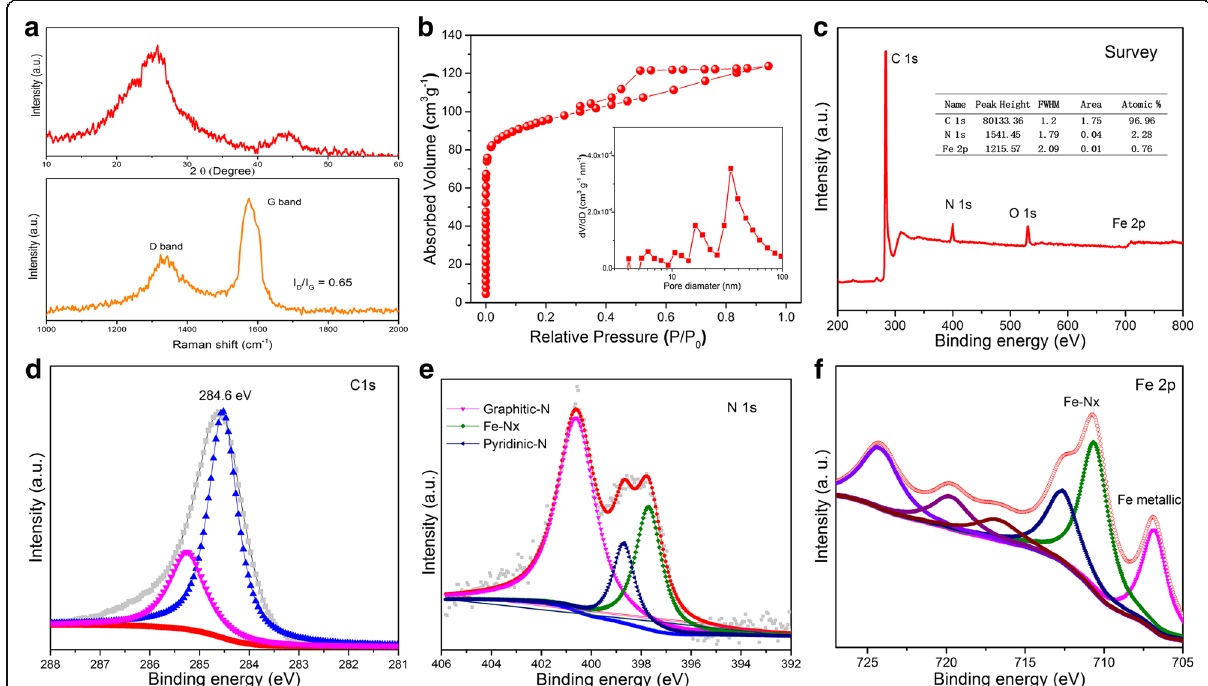
Fig. 3 XRD and Raman spectra of FN-800 ( a , top and a , down). N 2 sorption isotherms and of FN-800 ( b , the inset corresponds to pore diameter distribution). XPS spectra of FN-800: survey ( c ), C 1s ( d ), N 1s ( e ), and ( f ) Fe